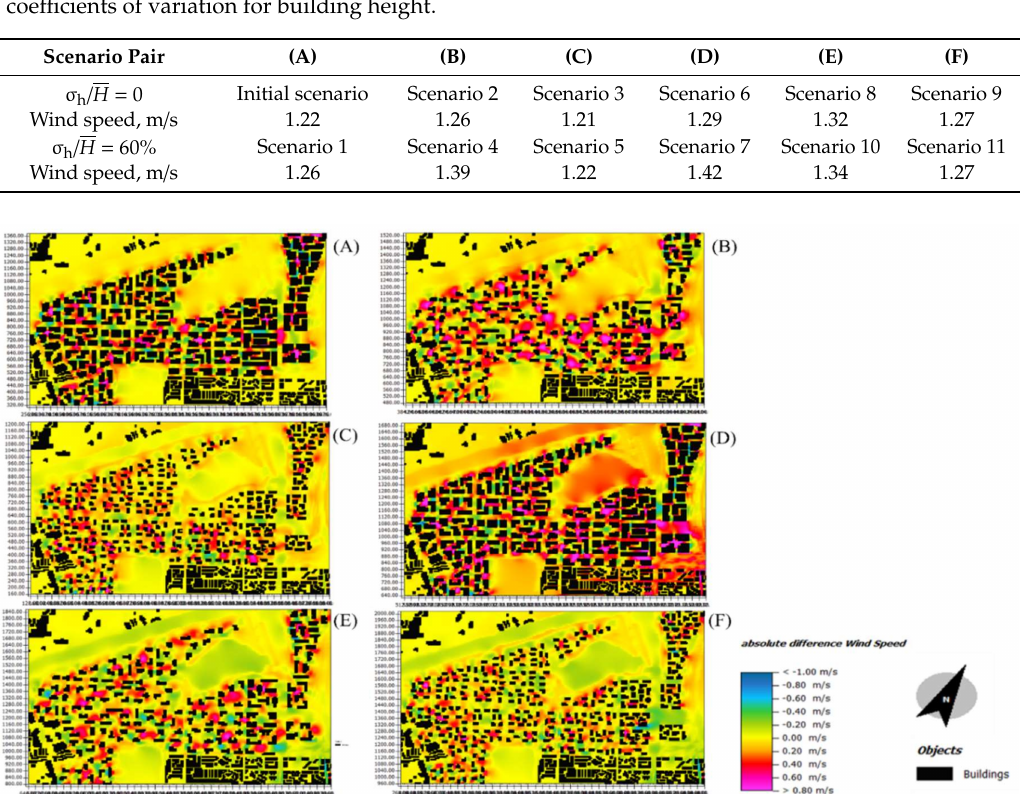
Figure 13. Wind speed di ff erence between each pair of scenarios with di ff erent coe ffi cients of variation for building height. (( A ): Initial scenario; ( B ): Scenario 2; ( C ): Scenario 3; ( D ): Scenario 6; ( E ): Scenario